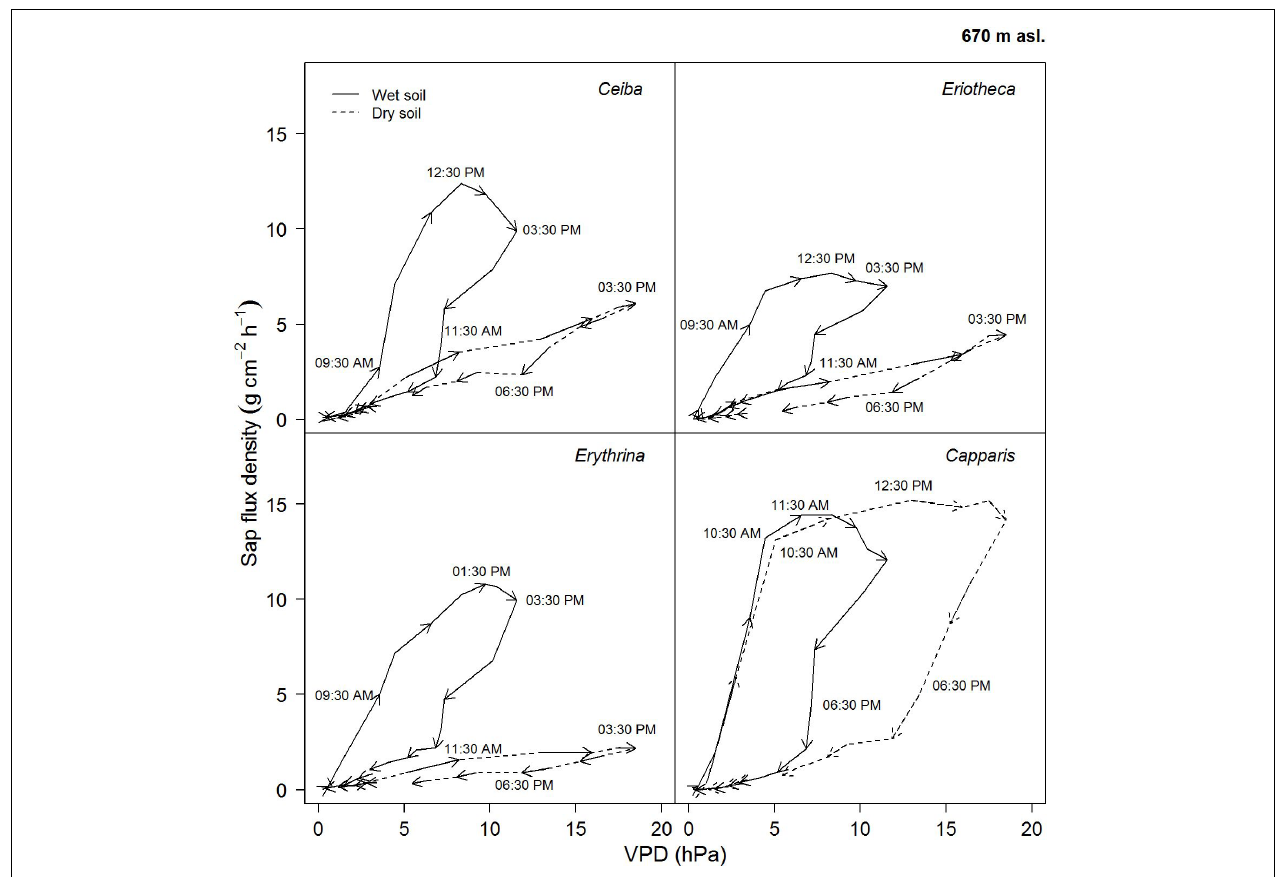
FIGURE 6 | Diurnal hysteresis loops showing the relationship between hourly sap flux density and VPD for dry (16.02.2015, SWC = 7.4%) and wet (13.04.2015, SWC = 25.8%) soil conditions. Solid line indicates wet conditions, dashed line dry conditions; arrows show direction of rotation with time of the day. Hourly averages were derived from simultaneous measurement of n = 4 trees on a sunny